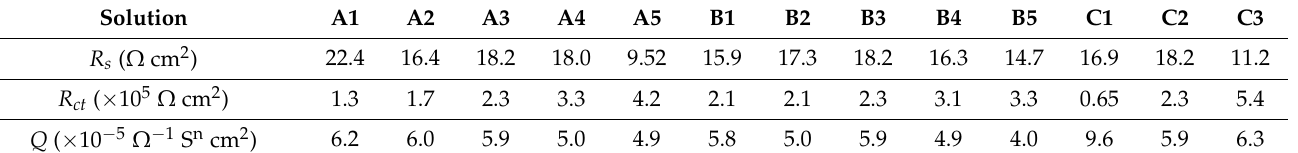
Table 2. The fitting results of EIS data.